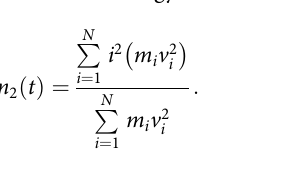
(white squares) indicate that the exponent γ of the second moment of the kinetic energy is smaller for progressively stronger